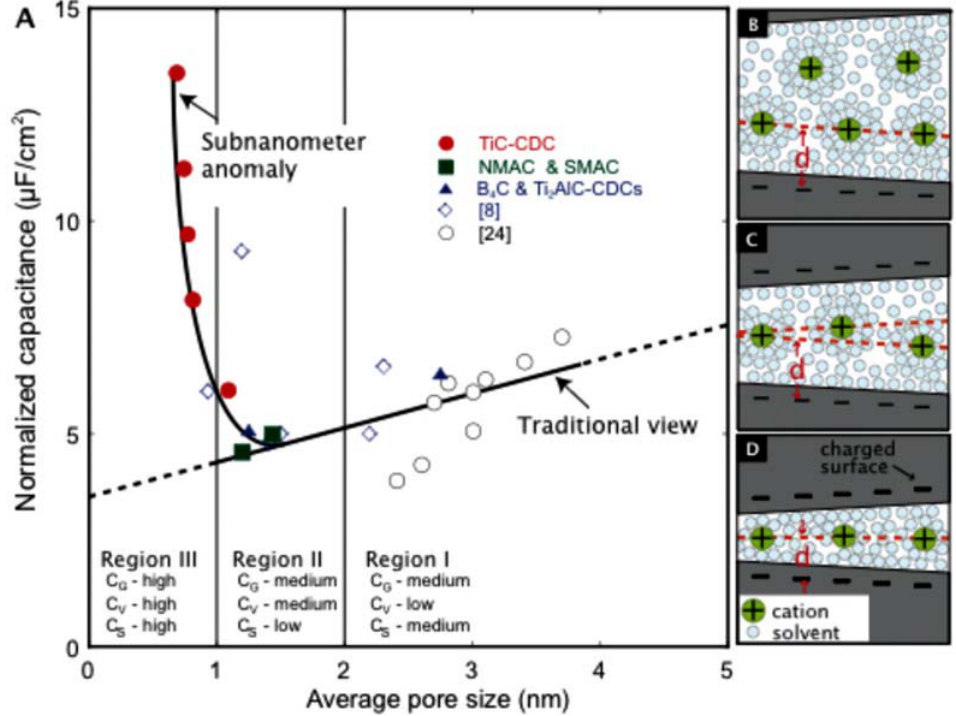
Figure 4: Plot of specific capacitance normalized by BET specific surface area for the carbons in the study and two other studies with identical elec- trolytes (A). The normalized capacitance decreases with pore size until a critical value is reached. It would be expected that as the pore size becomes large enough to accommodate diffuse charge layers, the capacitance would approach a constant value. CG, CV and CS are gravimetric, volumetric and normalized capacitances, respectively. Illustrations showing solvated ions residing in pores with distance between adjacent pore walls (B) grea- ter than 2 nm, (C), between 1 nm and 2 nm and (D) less than 1 nm illustrate this behavior schematically. (Reprinted from 20 with